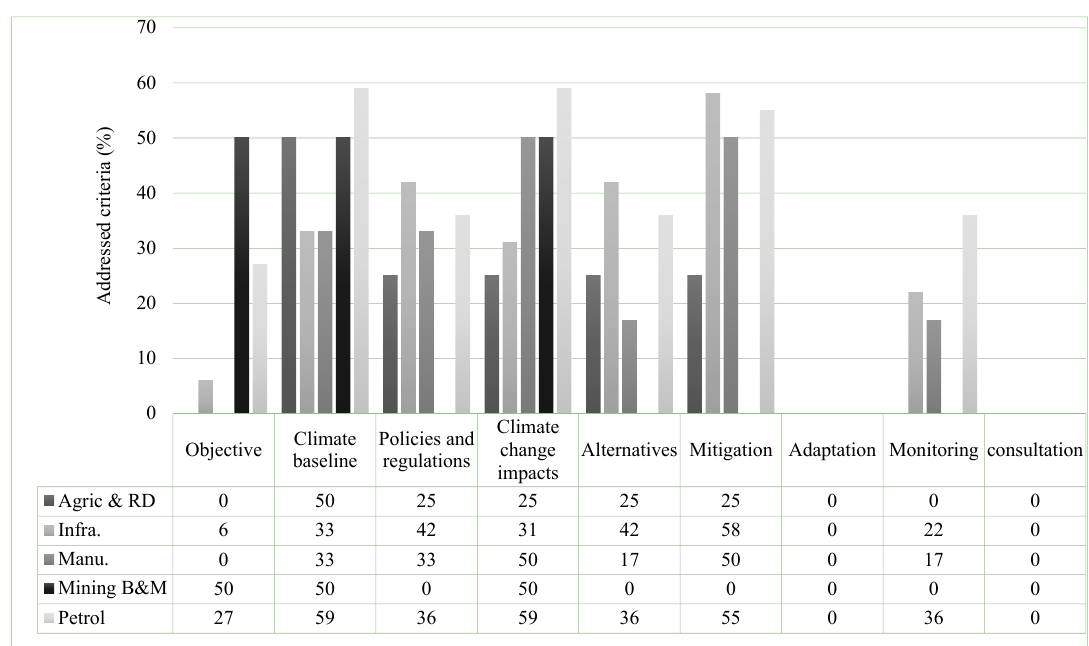
Figure 4. Percentage of criteria addressed per